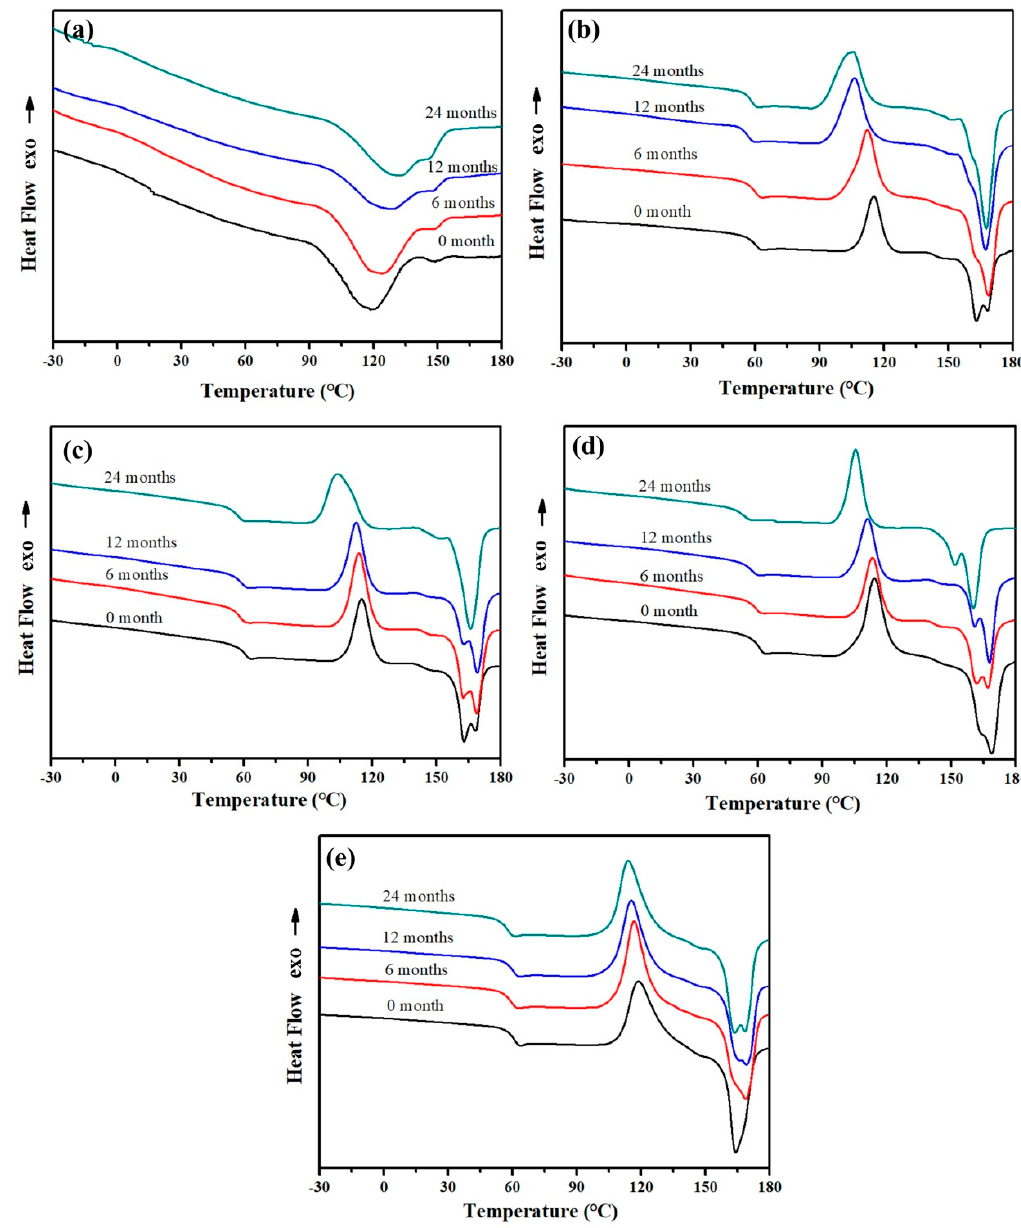
Figure 5. DSC melting traces of ( a ) PBAT, ( b ) PLA / PBAT-25, ( c ) PLA / PBAT-50, ( d ) PLA / PBAT-75 and ( e ) PLA before and after degradation for 6 months, 12 months, 24 months.